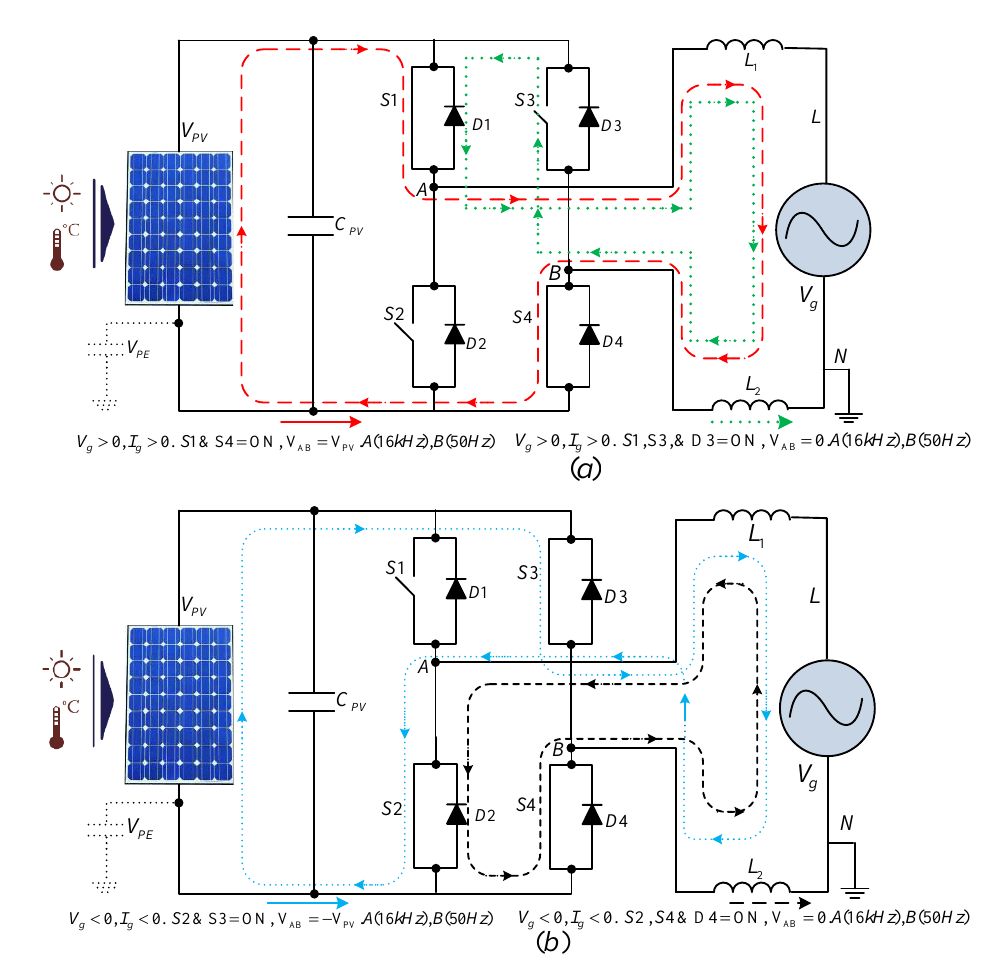
Figure 6. Hybrid modulation scheme for FB in case of ( a ) positive cycle and ( b ) negative cycle [29,30].